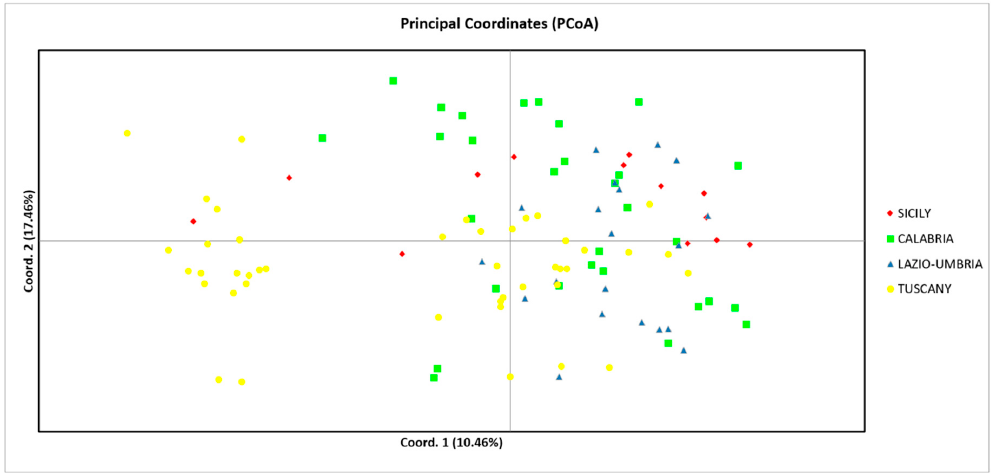
Figure 1. Principal coordinates analysis (PCoA) of large old chestnut trees from four different region situated in Central and Southern Italy.